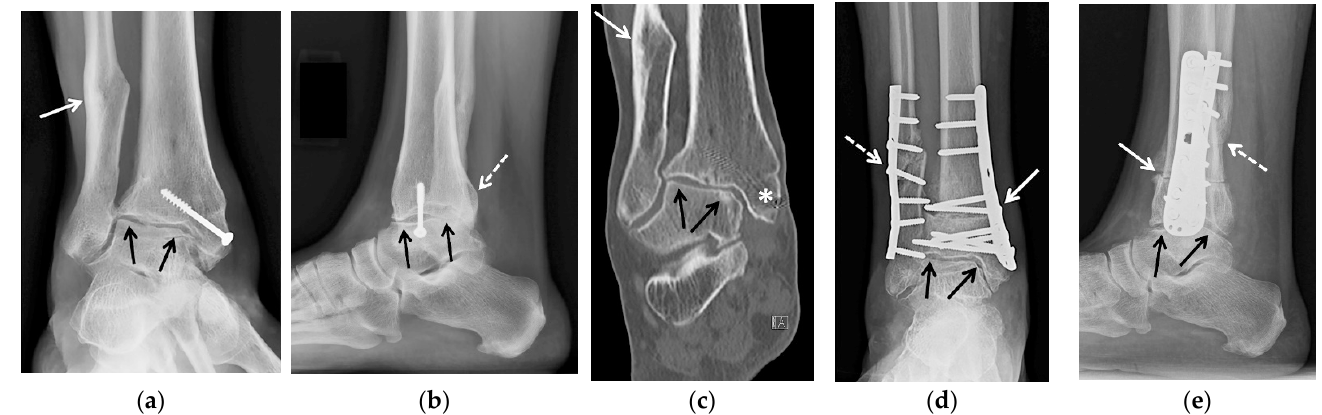
Figure 2. ( a – e ) A 47-year-old female with a history of remote trimalleolar right ankle fractures and posttraumatic tibiotalar joint osteoarthritis, treated with tibial wedge opening osteotomy and oblique fibular lengthening osteotomy. ( a ) Mortise and ( b ) lateral weight-bearing radiographs and ( c ) coronal reformatted CT image of the right ankle show a healed posttraumatic deformity of the medial malleolus with tibial valgus malunion transfixed by an interfragmentary screw (white asterisk in ( c )) and healed posttraumatic deformities of the fibula (white arrow) and of the posterior malleolus (dashed white arrow). Note the asymmetric narrowing of the tibiotalar joint consistent with advanced posttraumatic osteoarthritis (black arrows). ( d ) Mortise and ( e ) lateral 3 months postoperative weight-bearing radiographs show improved alignment of the distal tibia (white arrow) and fibula (dashed white arrow) status post osteotomies with decreased tibiotalar joint space narrowing (black arrows). Osteotomy sites demonstrate partial union at 3 months, a normal finding.